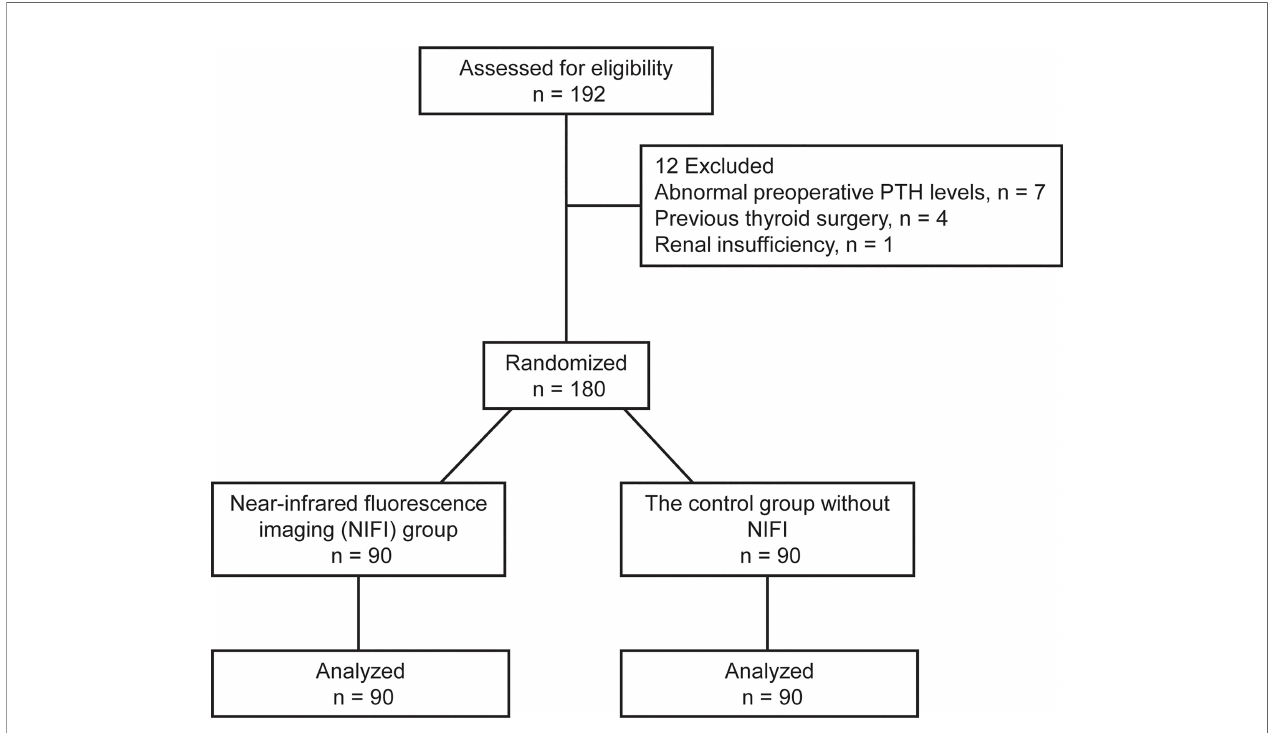
FIGURE 1 | Study fl